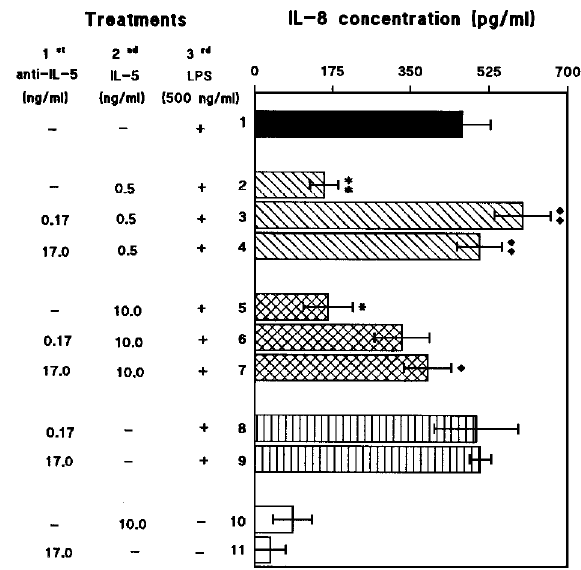
FIG. 2. BALF and bone marrow IL-8 levels in T. canis infected guinea-pigs sacrificed on different days post-infection ( n = 3 per day). Asterisks indicate a significant difference between infected ( j ) and non-infected ( w ) animals. * P < 0.05 and ** P < 0.01.